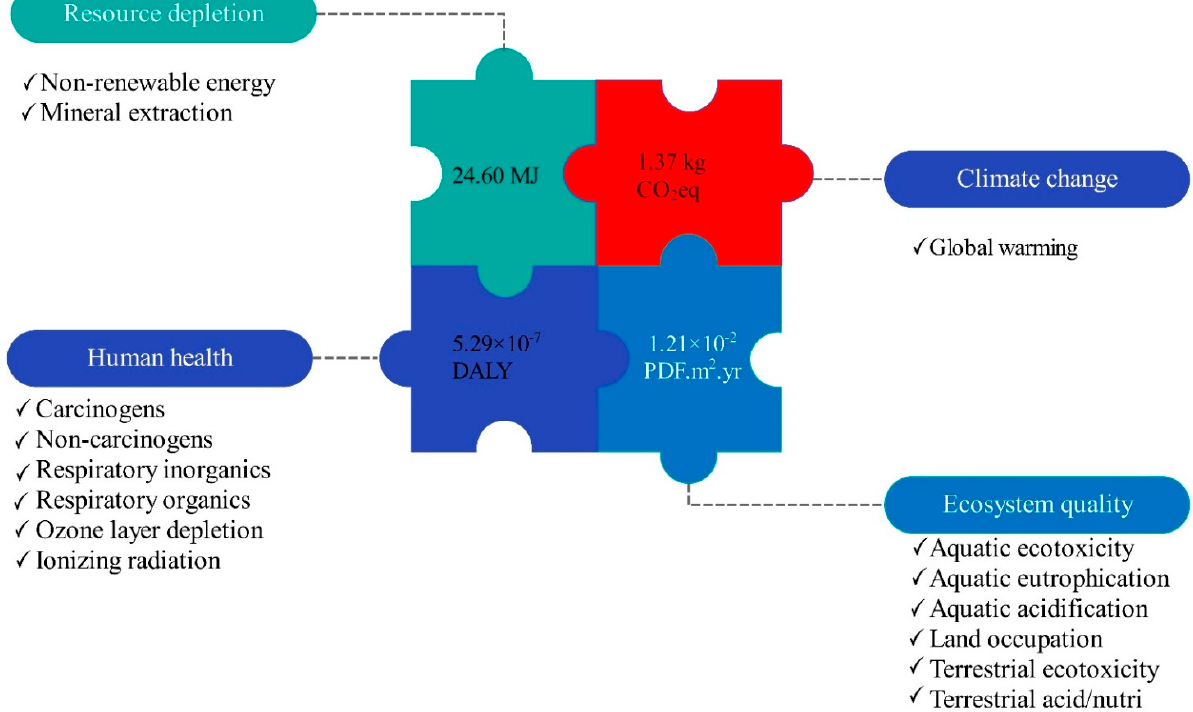
Figure 6. Damage assessment of olive kernel oil production (per 1 kg produced oil). Table 3. Environmental impacts of the olive kernel oil production system based on different damage categories.